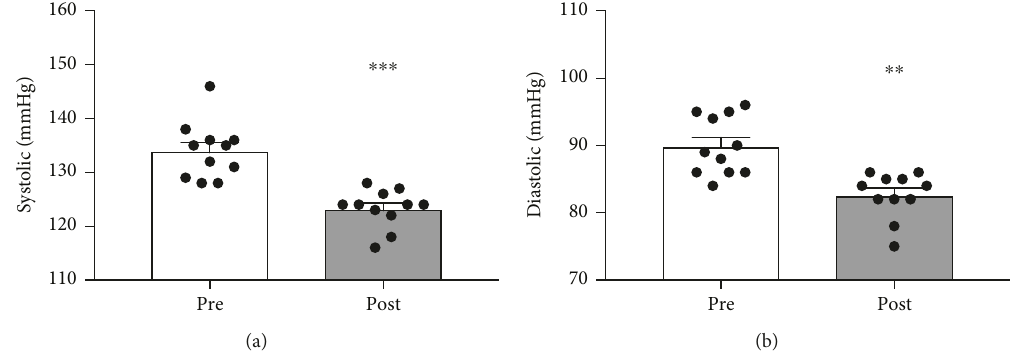
Figure 2: The e ff ect of a 90-day low-carbohydrate diet on systolic (a) and diastolic (b) blood pressures in women ( n = 11 ; ∗∗ p < 0 005 and ∗∗∗ p < 0 0005 ).